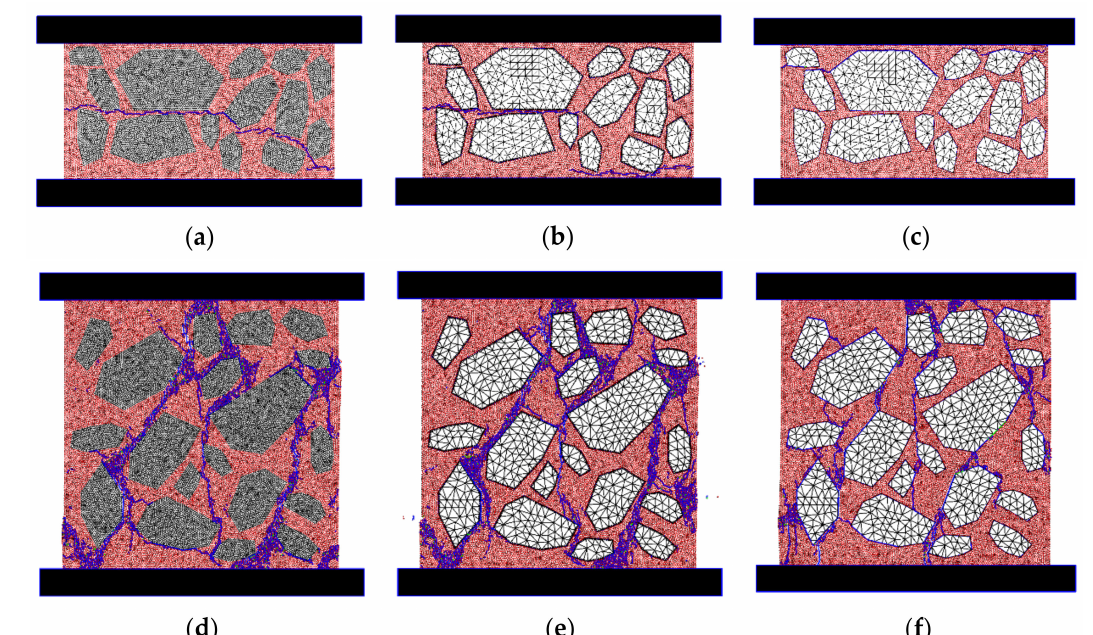
Figure 10. Final crack pattern for uniaxial testing– refined particle assembly: ( a ) Tensile test (DEM); ( b ) Tensile test (H-FEM-DEM-A); ( c ) Tensile test (H-FEM-DEM-B) [15]; ( d ) Compression test (DEM); ( e ) Compression test (H-FEM-DEM-A) and ( f ) Compression test (H-FEM-DEM-B)